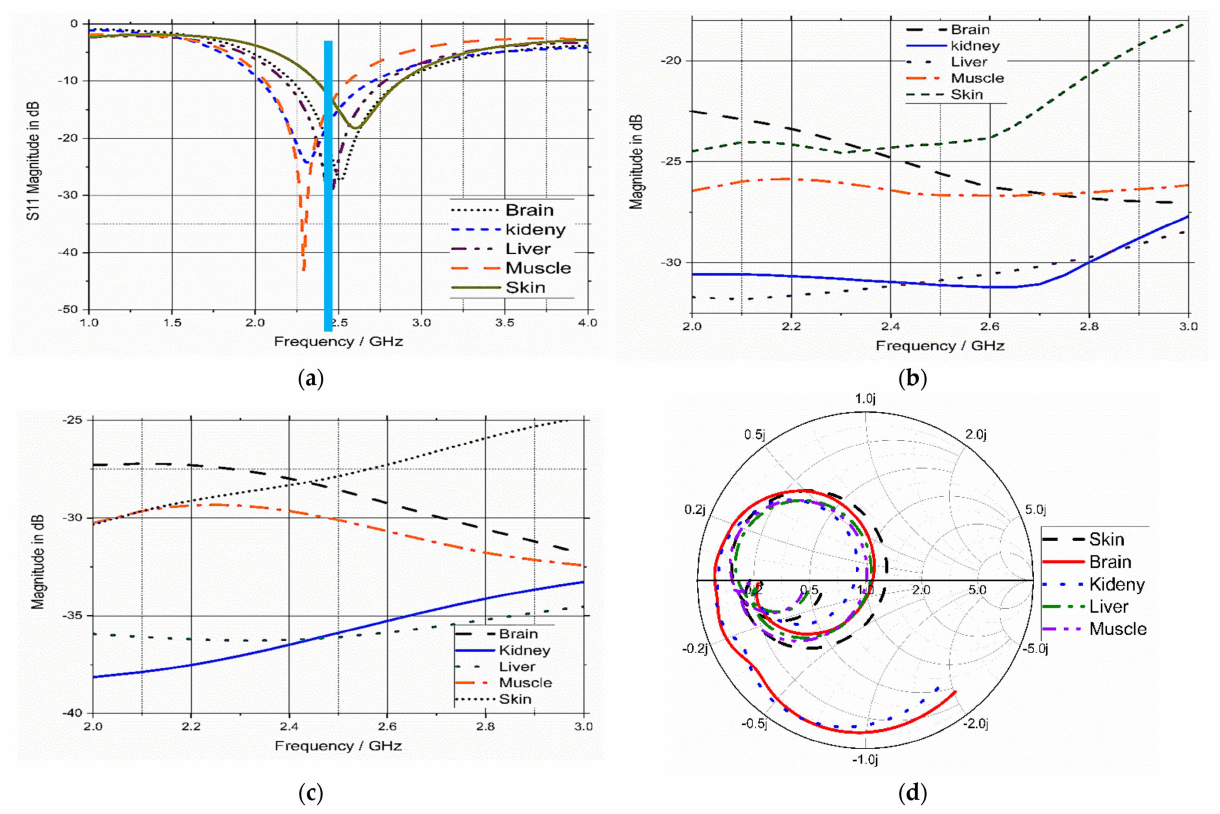
Figure 12. Simulated ( a ) S 11 parameter, ( b ) gain, ( c ) total efficiency, and ( d ) input impedance of the proposed